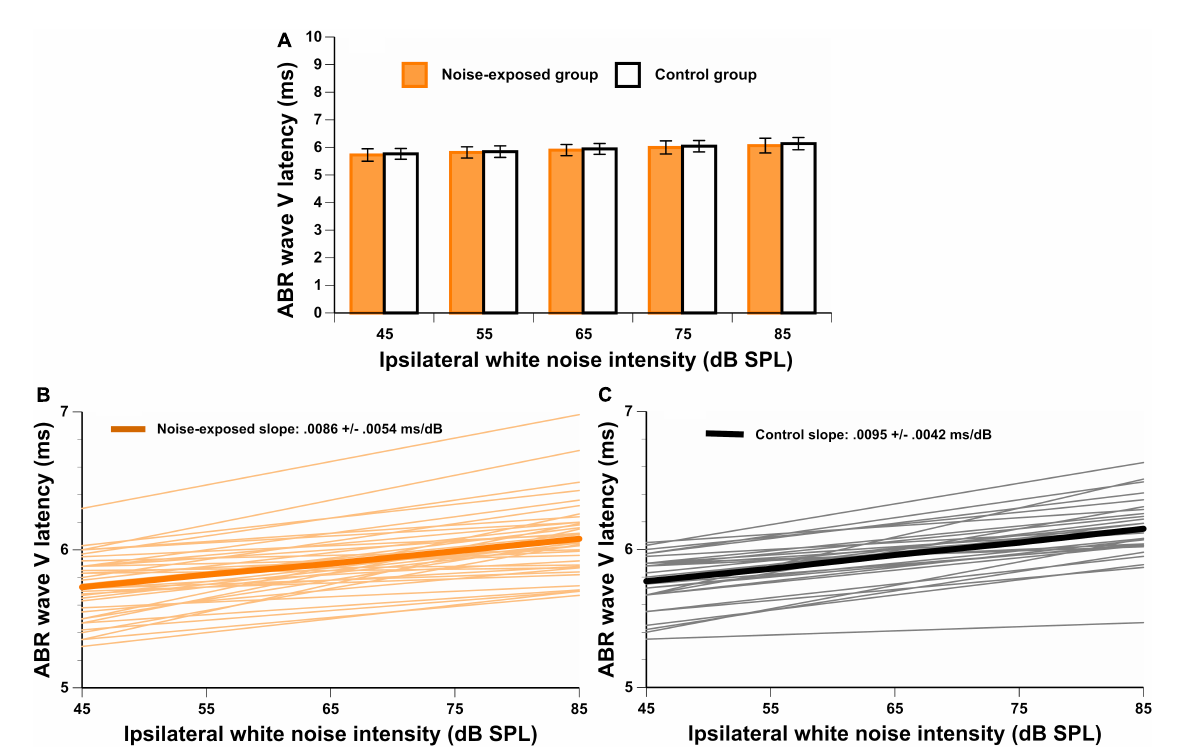
FIGURE5 (A) Wave V latencies for a stimulation level of 80 dBnHL with different ipsilateral white noise intensities (45, 55, 65, 75, and 85 dB SPL). In (B,C) , the ABR LAT-V Slope is illustrated for both groups. There are no significant differences between